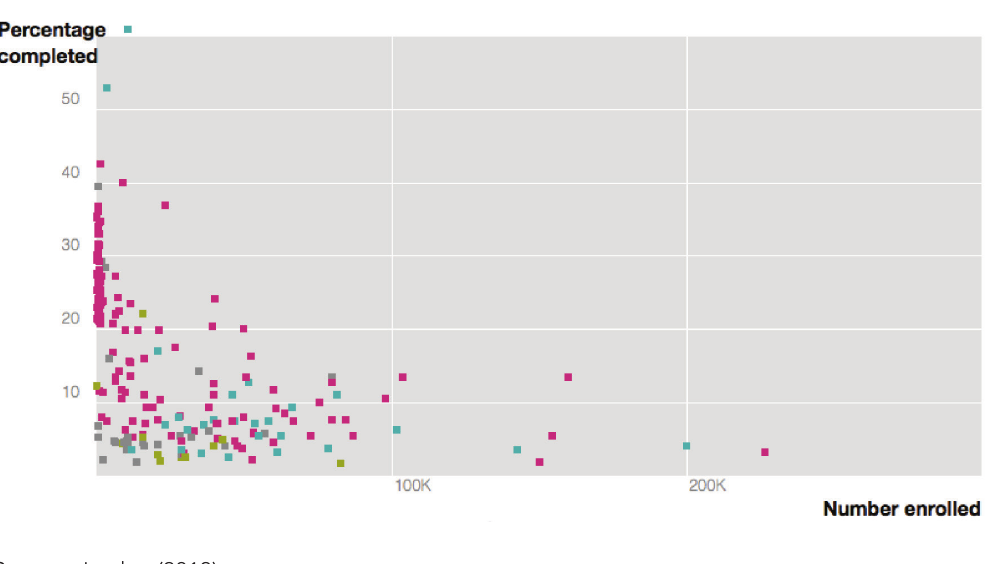
Figure 1: Screen capture of the MOOC completion rates visualization